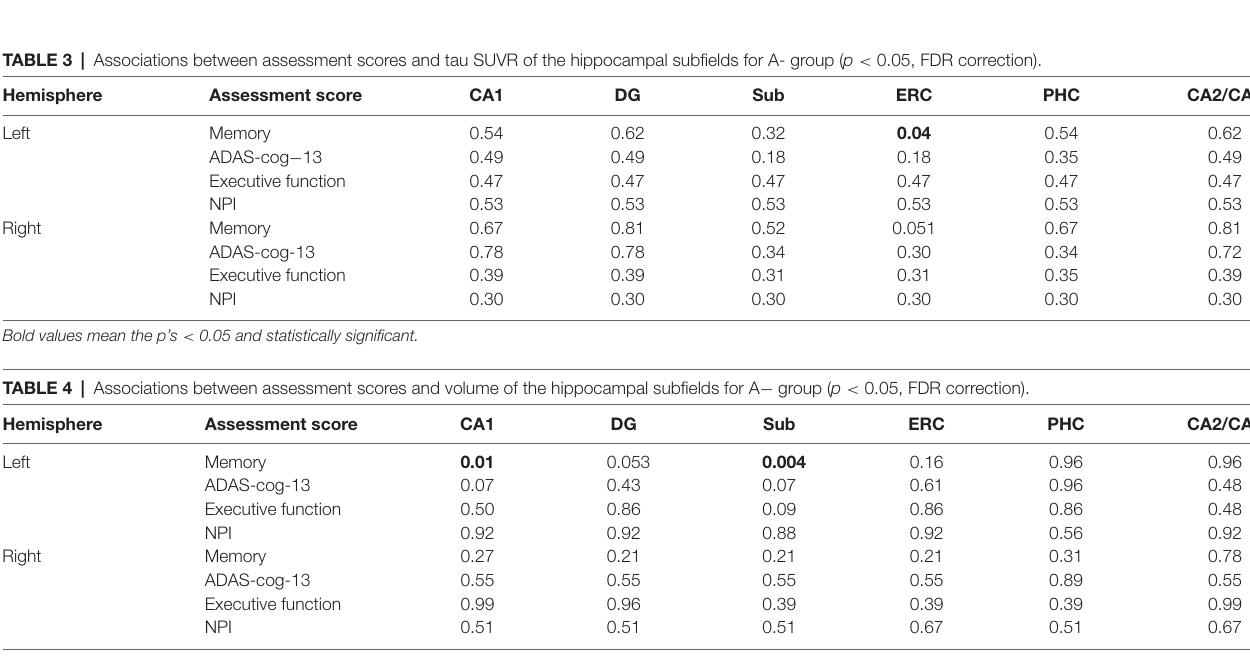
TABLE 2 | Volume and tau deposition of the hippocampal subfields between different amyloid status ( p < 0.05, FDR correction. n.s.: not significant). Hemisphere Volume